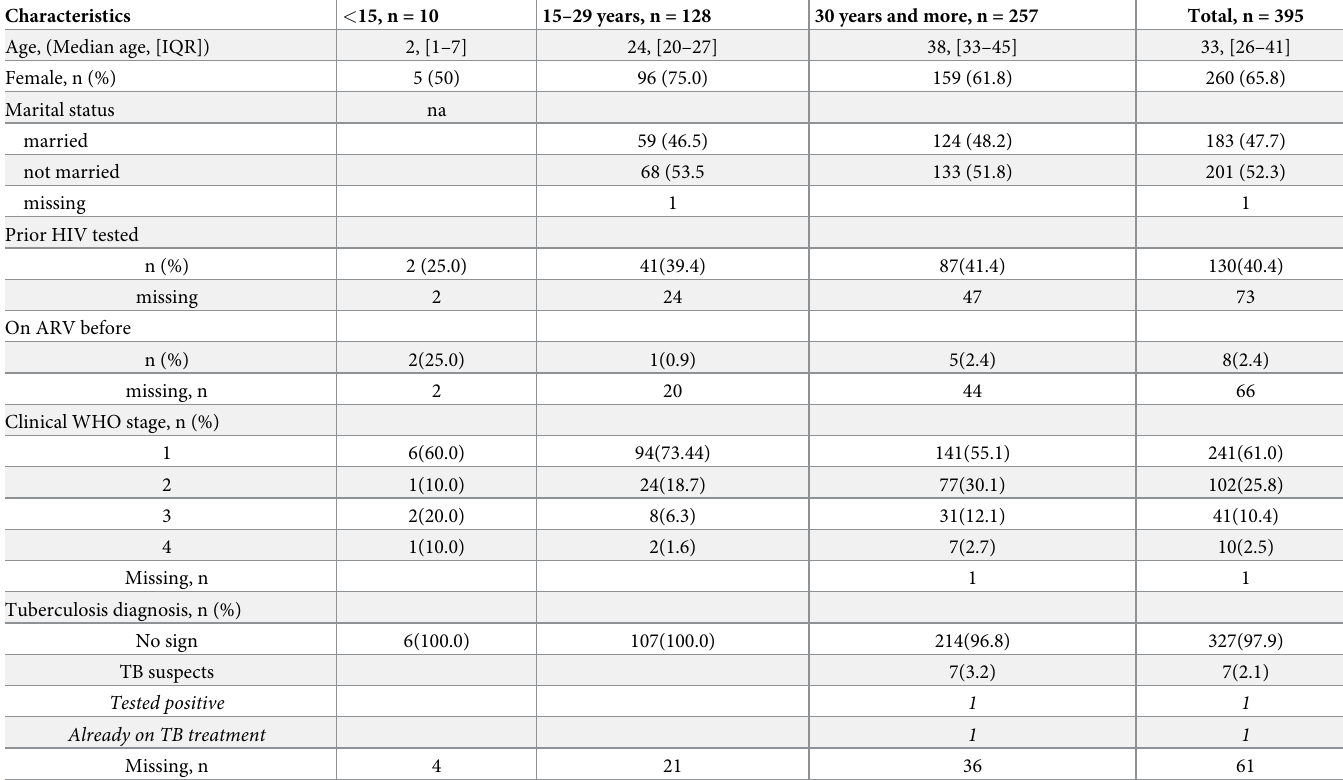
Table 1. Patients’ demographic and clinical characteristics at enrolment in test and start